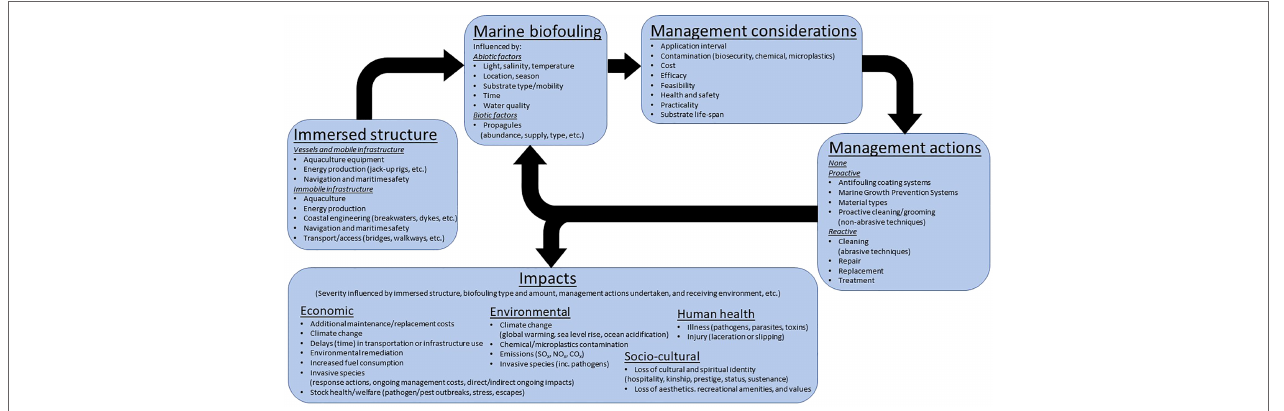
FIGURE 1 | Influences, management considerations, and impacts of marine biofouling on immersed